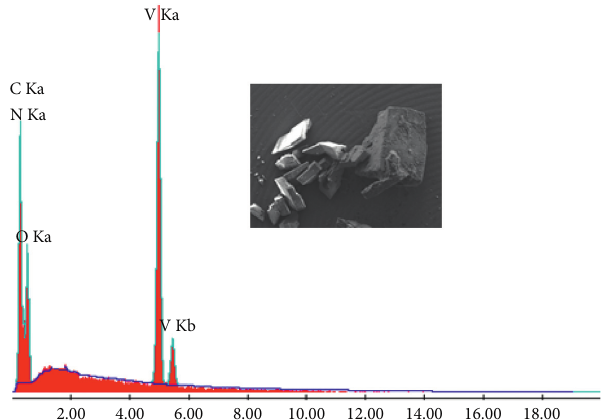
Figure 4: SEM-EDX of the(C